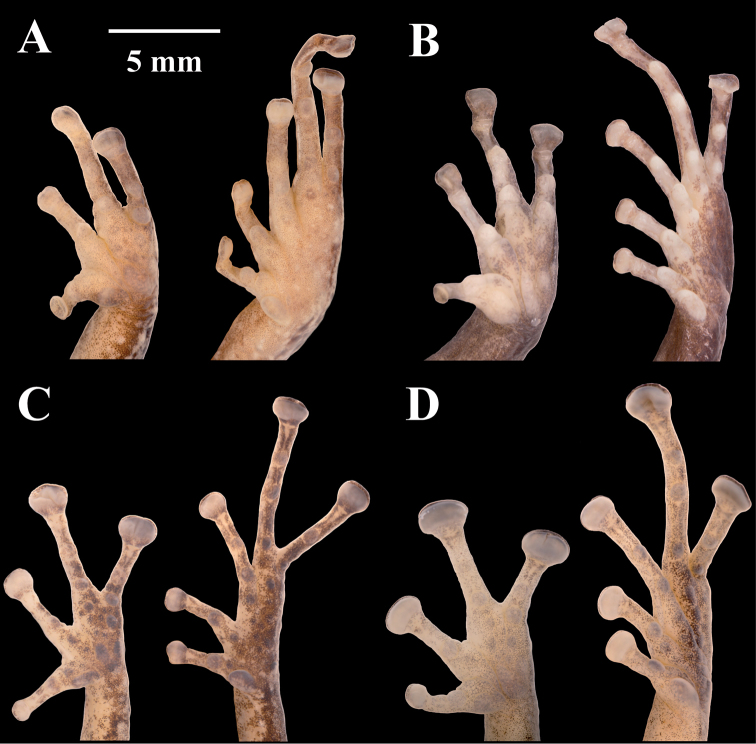
Palmar and plantar surfaces of Pristimantis
lutzae sp. nov., Pristimantis
multicolor sp. nov., Pristimantis
nangaritza sp. nov., and Pristimantis
phoxocephalus. Photographs of hand and foot of the holotypes (except for P.
phoxocephalus) of the following species: APristimantis
lutzae sp. nov.: QCAZ 37546, female BPristimantis
multicolor sp. nov.: QCAZ 47213, male CPristimantis
nangaritza sp. nov.: QCAZ 41710, female DPristimantis
phoxocephalus: QCAZ 58463, female from the type locality. All specimens are shown at the same scale.